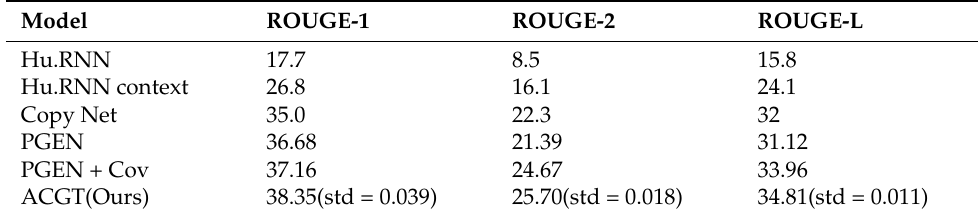
Table 4. ROUGE score of each model on LCSTS dataset (word-based).